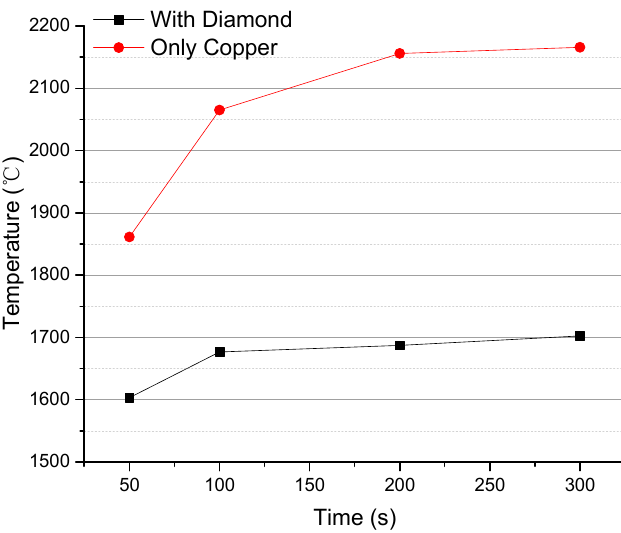
Figure 5. Diamond composite anode vs. common tungsten film anode in surface temperature under the same conditions.